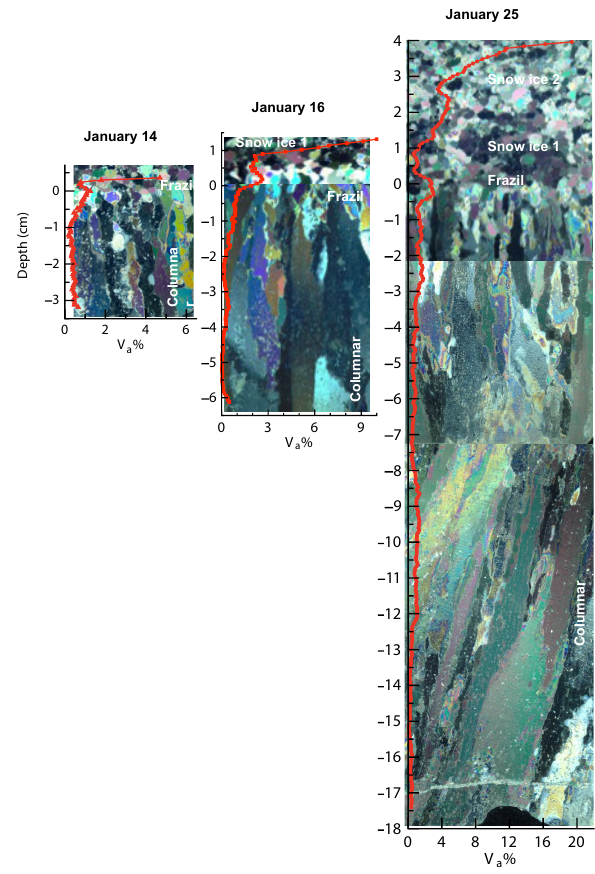
Figure 4. Sea ice microstructural images overlain by the air volume fraction (red curve) for 14, 16 and 25 January. The x scale differs for each date in order to visualize vertical change. The zero depth is fixed at the boundary between granular and columnar ice. Through the studied period ice grew from the bottom increasing the columnar layer, as well as by the top due to additional formation of snow